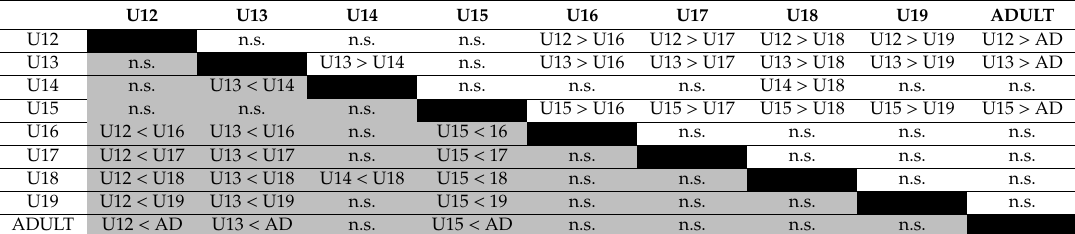
Figure 4. Differences in fat-free mass among different age groups.